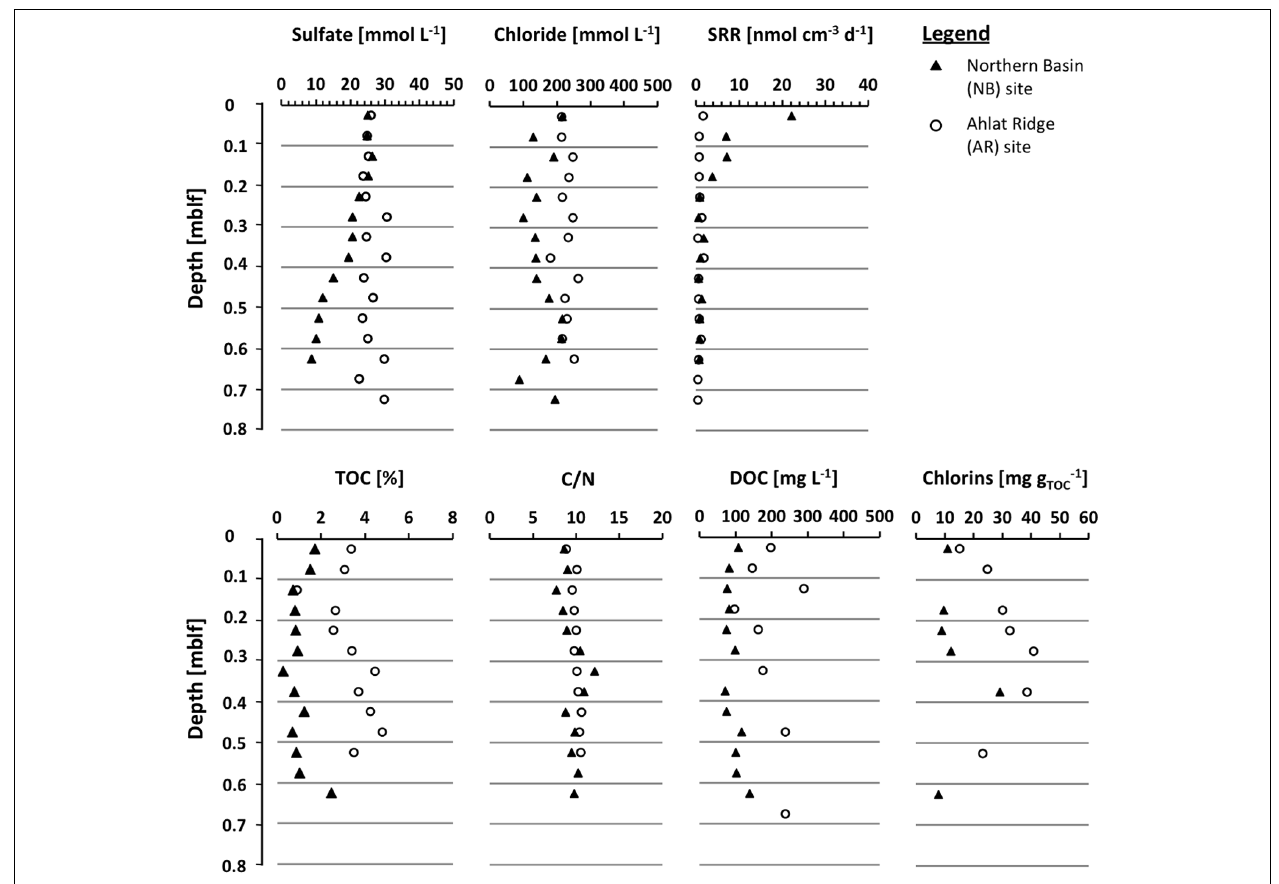
FIGURE 2 | Depth profiles of the gravity cores (0–0.75 mblf) from the Northern Basin site (NB, black triangles) and theAhlat Ridge site (AR, open circles) for pore water concentration of chloride and sulfate, sulfate reduction rate (SRR),TOC concentrations, C/N ratio, DOC concentrations, and